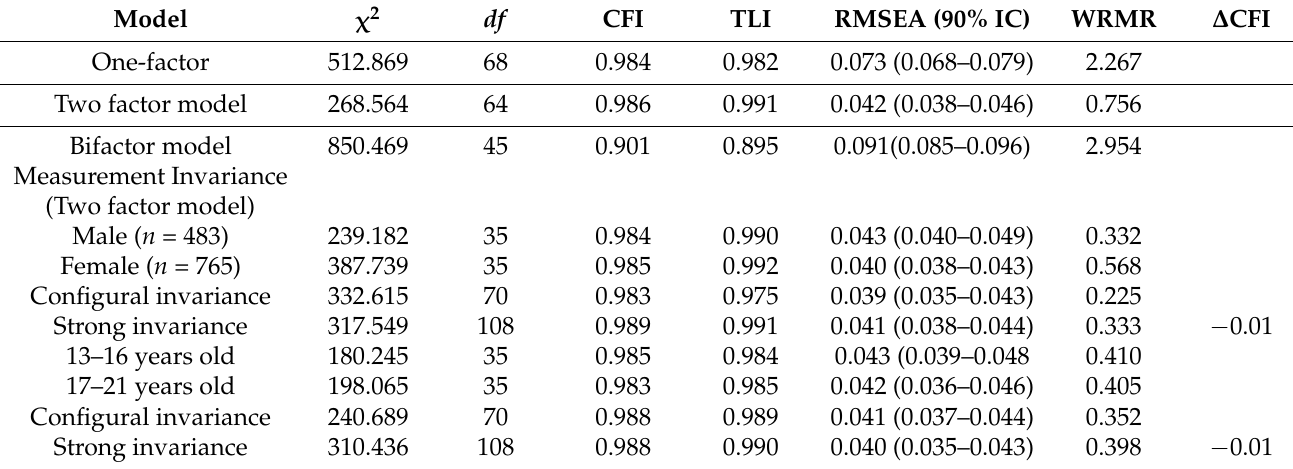
Table 4. Goodness-of-fit indices for the hypothetical models tested and measurement invariance across gender and age.